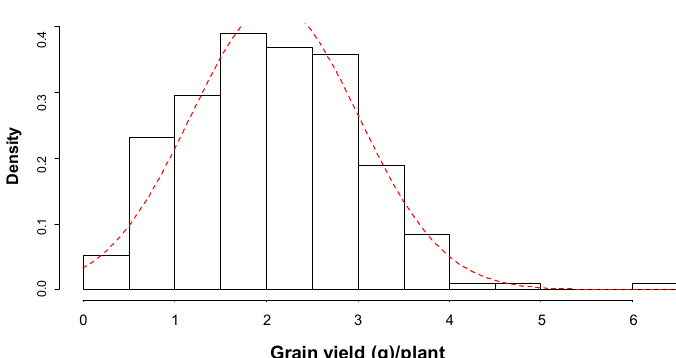
Figure 2. Frequency distribution of yield traits (panicle/plant—upper panel; grain/panicle—middle panel; and grain yield (g)/plant—lower panel) of the F 2:3 progenies derived from Cocodrie × N22 under greenhouse drought conditions. Density = frequency/interval. Frequency = area of the bar representing the number of F 2:3 lines in a class.